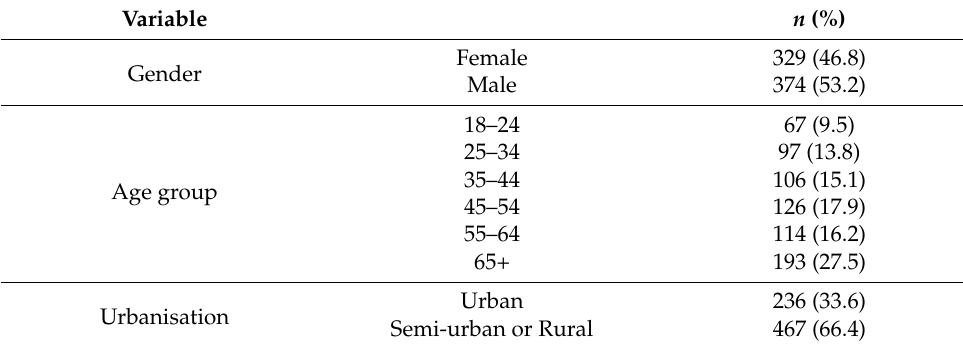
Table 1. ESRA2 Finland: Characteristics or car